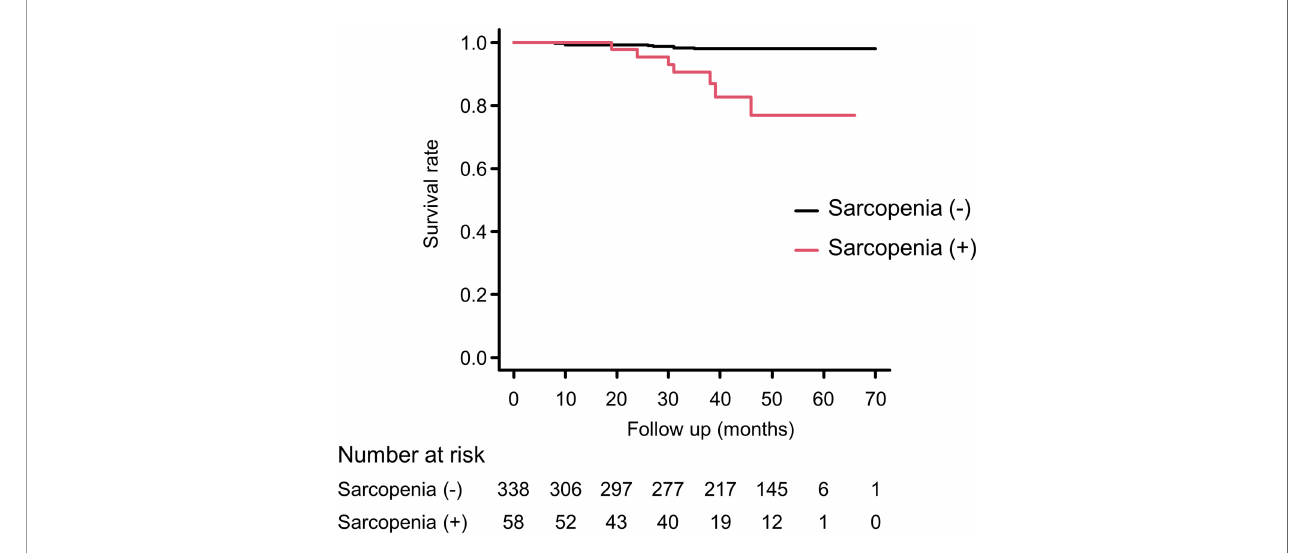
FIGURE 2 | Kaplan-Meier survival curve according to the presence or absence of sarcopenia. According to the log-rank test, p < 0.001.